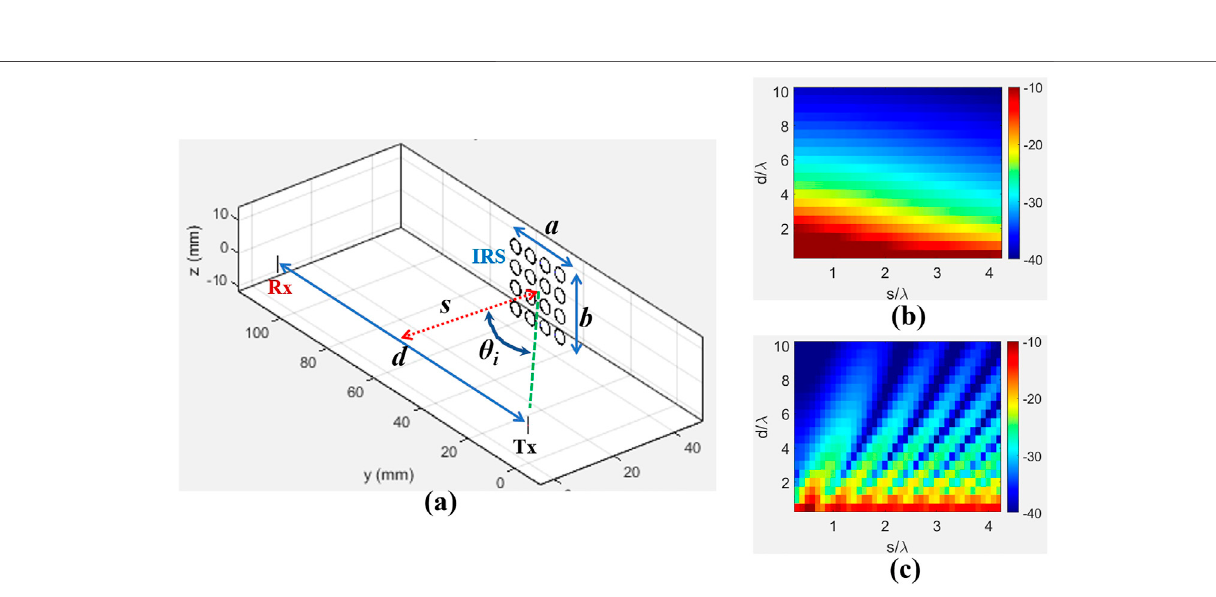
FIGURE 10 | (A) Schematic diagram of a Dipole-based Tx-Rx system (separation d ) operating at 28 GHz. An IRS having 4 × 4 con fi guration of loops ( r (cid:1) 0.2 λ and p (cid:1) 2 r +2 mm)isplacedatadistance s asshown.Two-dimensionaldistributionofpath-lossi.e.S21fordifferent s / λ and d / λ calculatedusing: (B) Theoreticalformulafrom Ozdogan et al. (2020) i.e. PL theory , (C) MoM simulations using proposed approach, i.e. | S withIRS 21